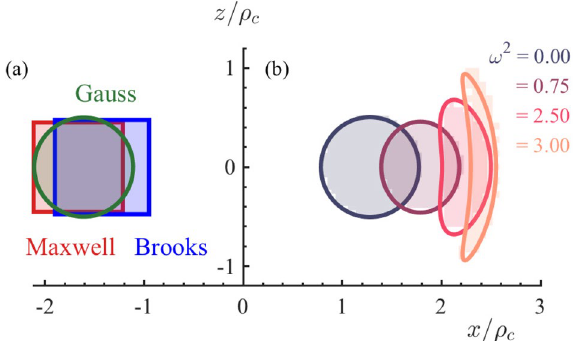
Figure 2. Cross-sections of the optimal coils. ( a ) Designs proposed by Gauss 3 , Maxwell 4 , and Brooks 6 . ( b ) Results obtained in this work. The cross-section evolves from near-circular to elliptic to sickle-shaped as ω increases. The shading represent the local wire density n ( r ) computed on a 30 as guides to the eye. The wire density is seen to switch from 0 to n 2 with few or no intermediate values. The numbers on the axes are x and z coordinates in units of ρ c . The legend indicates the magnitudes of (ω/ω c )